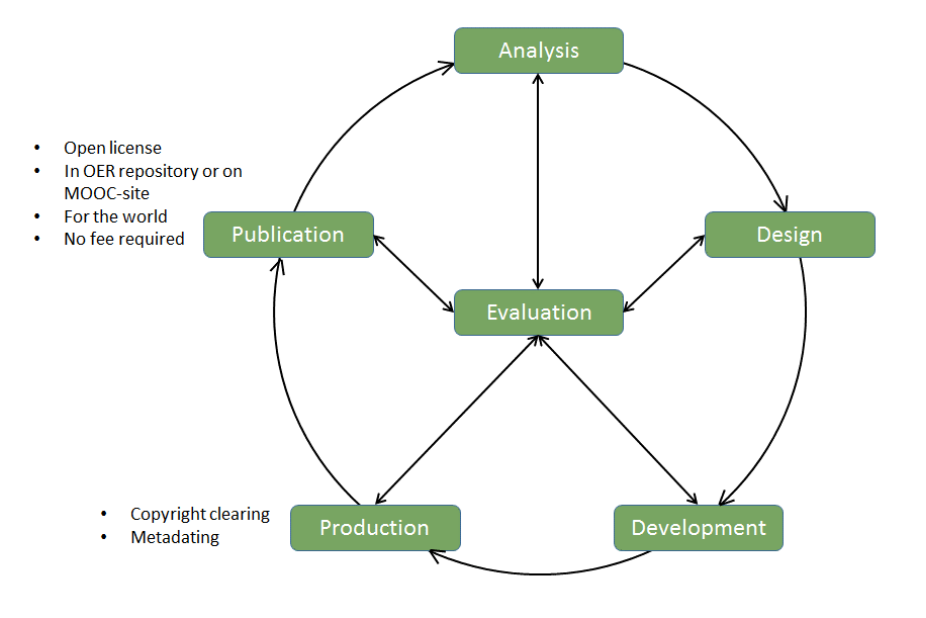
Figure 2. Model for the cycle of open sharing and reuse of learning materials and